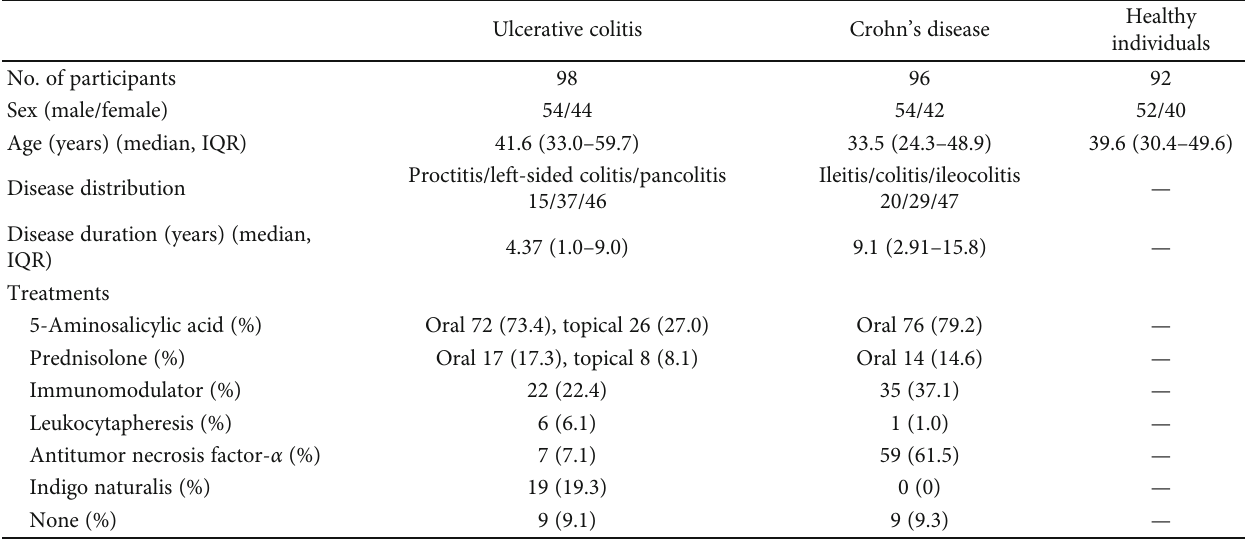
Table 1: Baseline characteristics of the study population used to evaluate LRG concentrations in the sera of patients with IBD and healthy